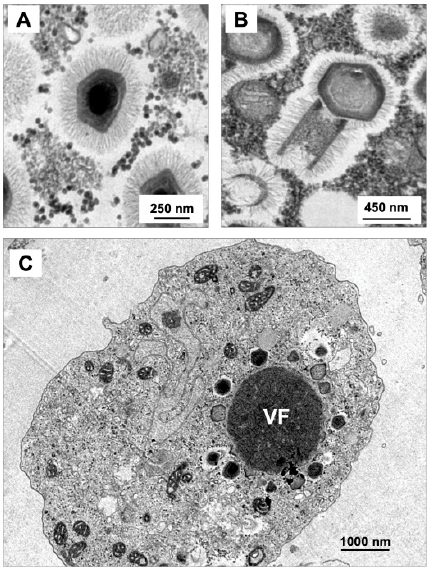
Figure 3. Transmission electron microscopy of Mimivirus ( A ) and Tupanvirus particles ( B ). ( C ) Tupanvirus viral factory, occupying a large portion of Acanthamoeba castellanii cytoplasm. VF: viral factory.